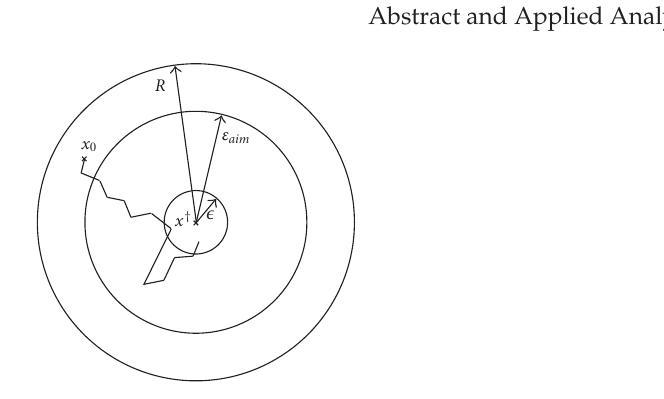
Figure 1: Geometry of the problem. The iterates x n approach x † as long as Δ 2 (cid:4) x n ,x † (cid:5) ≥ (cid:8) . The auxiliary number (cid:8) is chosen such that, if the iterates enter the Bregman ball with radius ε aim around x † , the following iterates stay in that